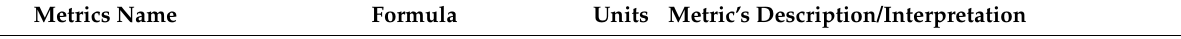
Table A6. Metrics characterising the area and the height structure of shrub and tree patches in a buffer of 50 m from the border of Natura 2000